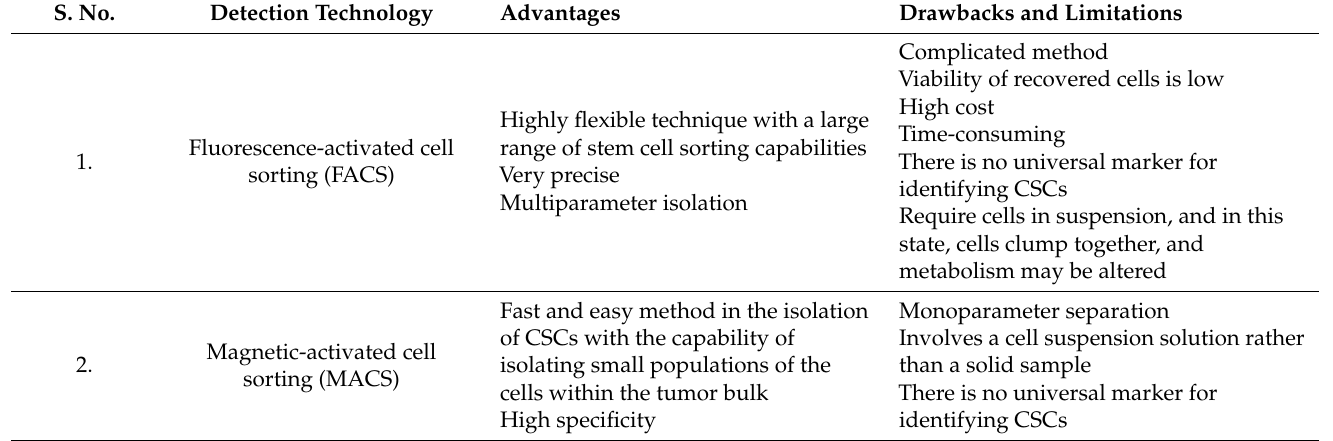
Table 1. Approaches for cancer stem cells (CSCs) detection and